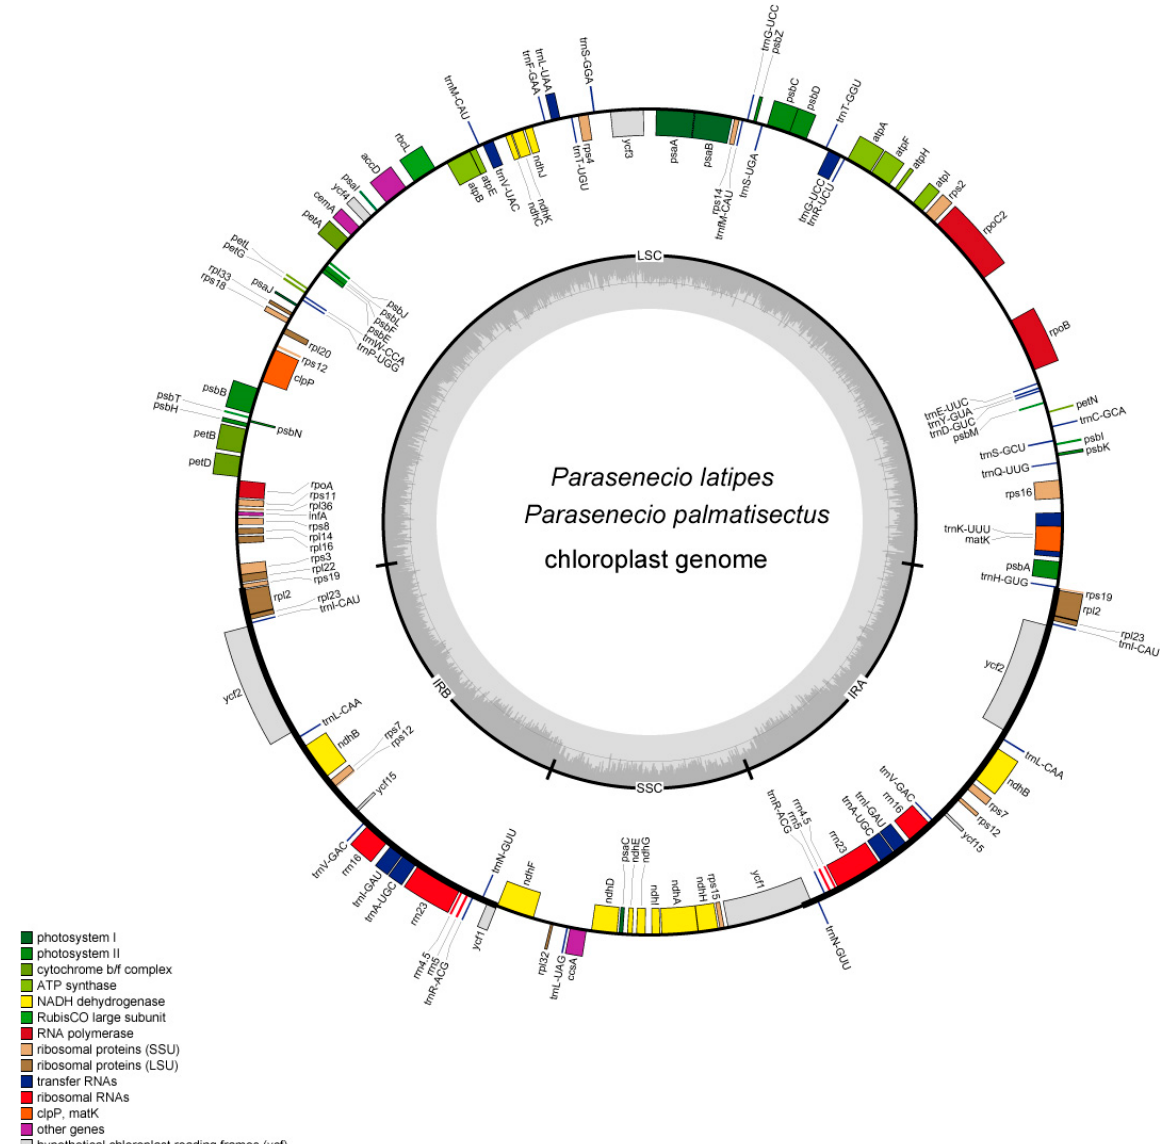
Figure 2. The cp genome maps of P. latipes and P. palmatisectus. Genes shown on the outside of the circle are transcribed clockwise, and genes inside are transcribed counter-clockwise. Genes are color-coded to indicate functional group. The darker gray inner circle corresponds to the GC content, whereas the lighter gray indicates the AT content. Table 1. Comparative analyses of cp genomes among 10 species of Senecioneae. The cp genomes of eight Senecioneae species were selected for comparison with the two Parasenecio species (Table 1). As expected, all the plastomes of the 10 species showed a typical quadripartite structure. The plastomes of the 10 Senecioneae species were 151,118 to 151,315 bp, with little variation in length between the newly generated and published genomes. The total GC contents of the plastomes were highly similar (37.4 to 37.5%), while the different regions (LSC, SSC, and IR) had slightly variable GC contents. There was little difference in total genes (131–134) and CDS (86–89) between Parasenecio and the other genera of Senecioneae. The S. jishouensis species has the most genes and two Parasenecio species have the least